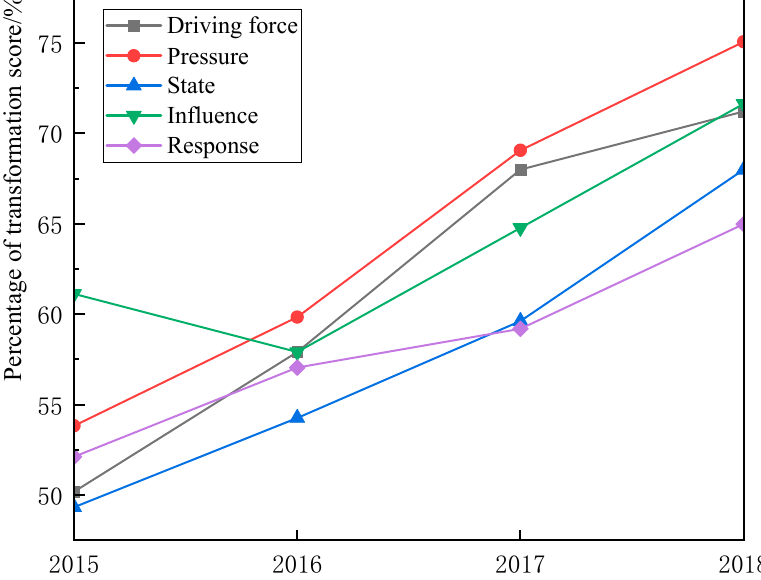
Figure 10. Scoring percentage of subsystems in comprehensive economic transformation of coal- based energy cities.